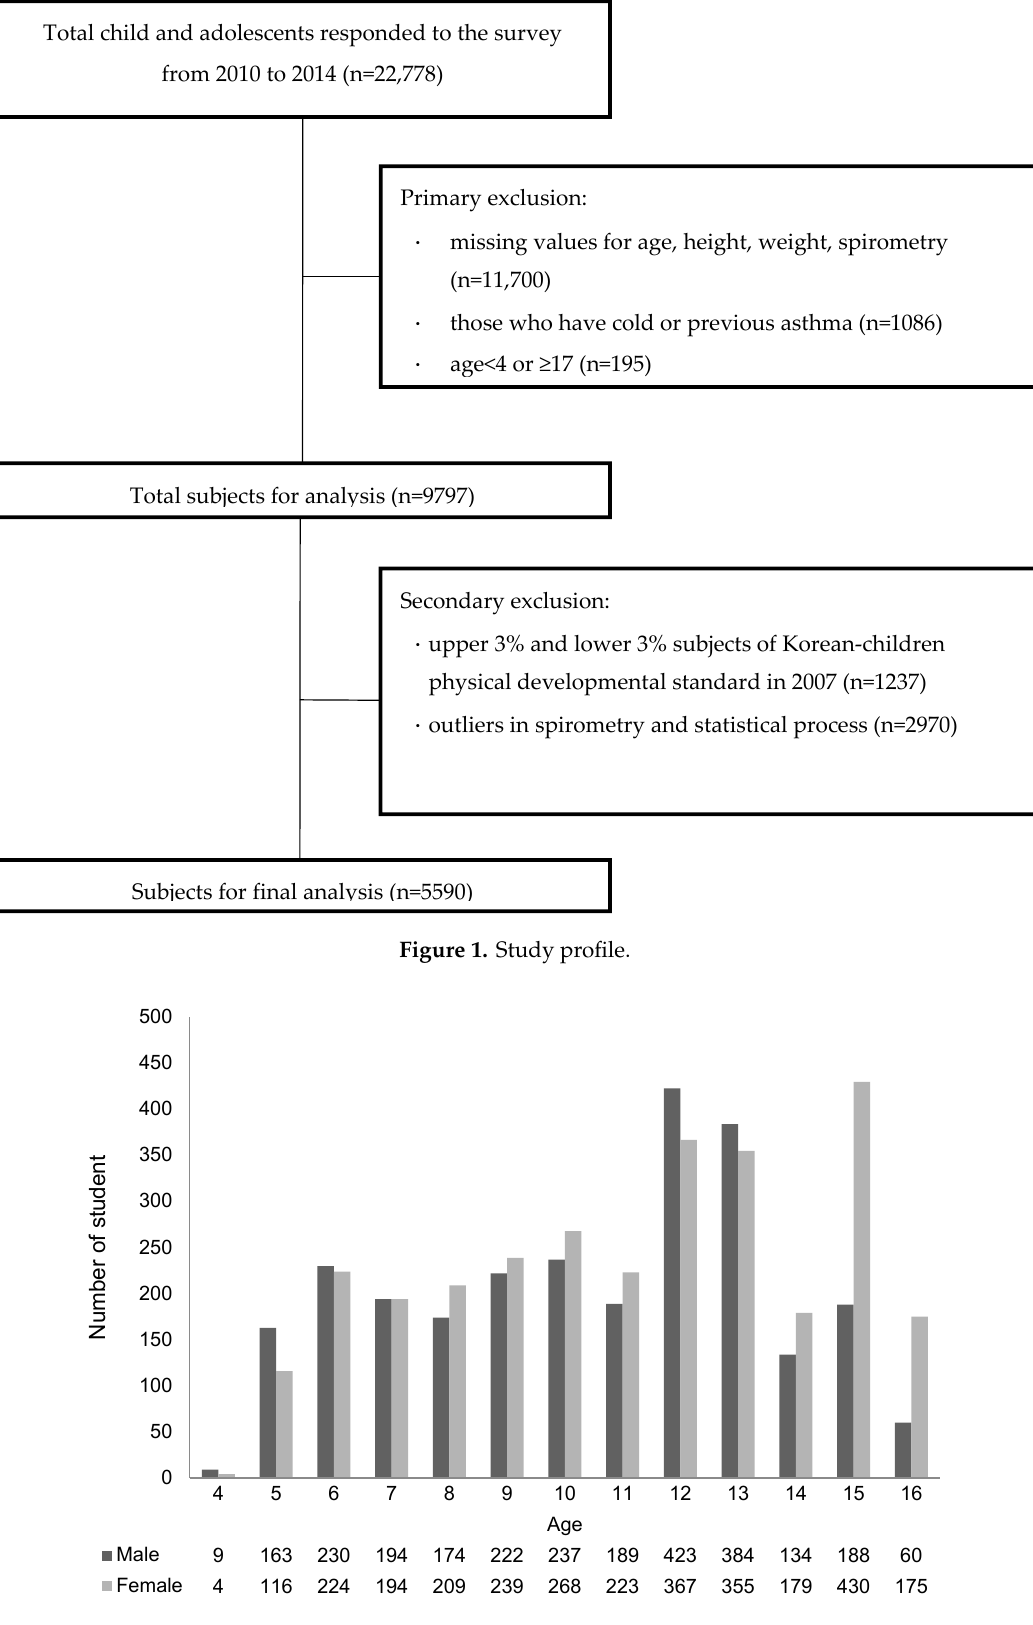
Figure 2. Age distribution of subjects by sex.